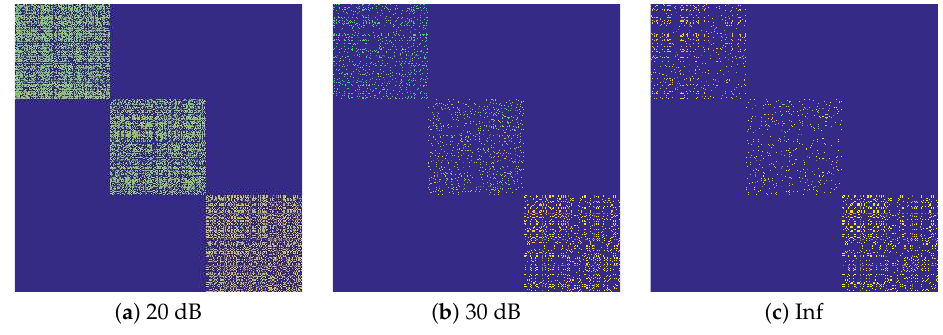
Figure 2. Visualization of various graph weights: ( a ) η = 0.9, γ = 0.8; ( b ) η = 0.7, γ = 0.9; and ( c ) η = 0.3, γ =